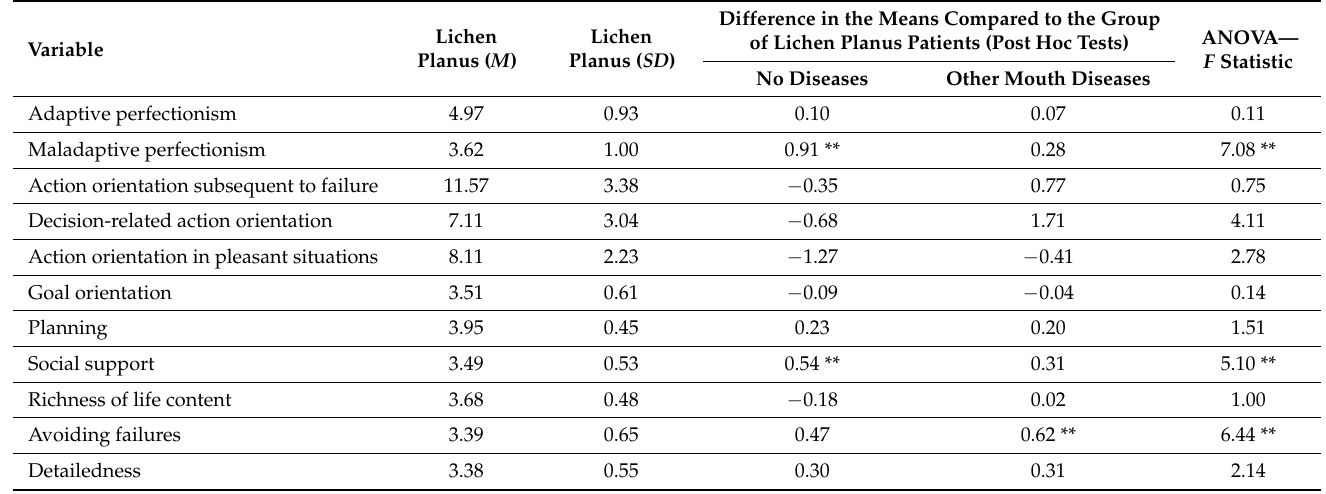
Table 3. Comparison of mean results of patients with lichen planus with results of other respondents— components of personality associated with action orientation.